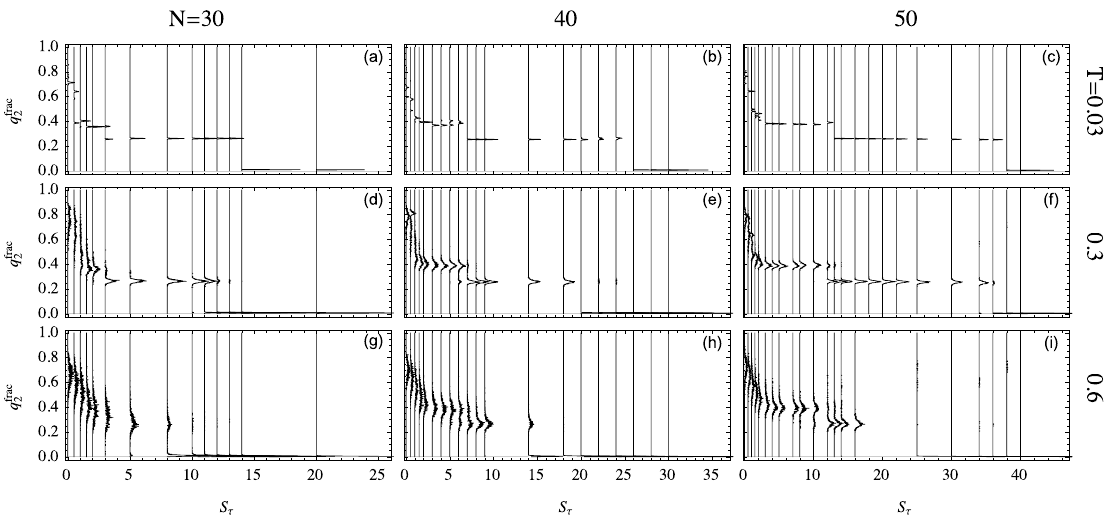
Figure 6. Distributions of q frac for the semiflexible helical polymers with N = 30, 40, and 2 50 monomers. Histograms are shown vertically with each baseline aligned with the particular S τ value on the horizontal axis. Each column represents a different system size and rows represent three specific